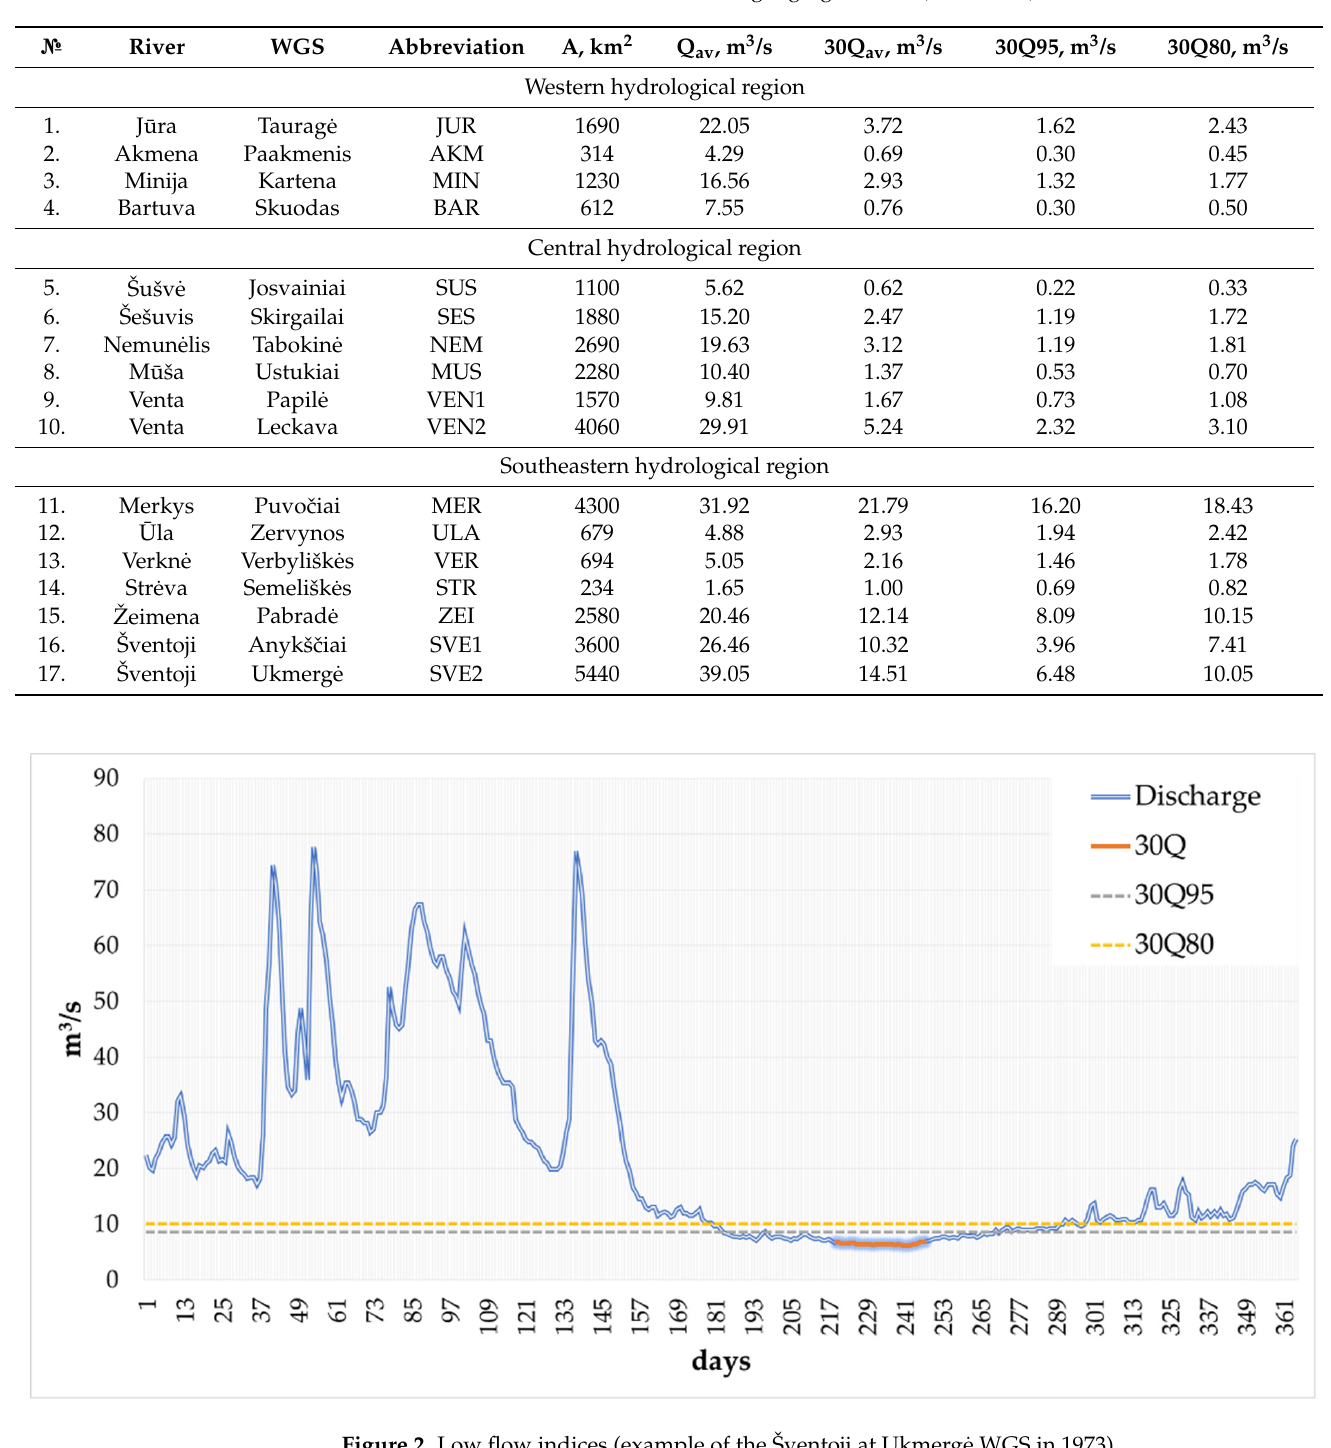
area in km 2 ). Modular coefficients for the low-flow period K = 30Q i /30Q av (30Q i is the discharge in year i, and 30Q av is the average discharge for the entire period of observa- tion) were used to estimate the regularities and to examine how low flows differed by decades (1961–2020) in the rivers from the different hydrological regions. This relative coefficient K enables a comparison of the rivers with different runoff values. To quantify the information incorporated in hydrographs, the HydroOffice software package [30] was applied. The HydroOffice tool FDC (flow duration curves; version 2.1) is often used to assess low flows. It was selected to calculate 30Q95 and 30Q80. FDC can be created from the entire imported time series or defined parts, such as annual or monthly segments. The HydroOffice tool TLM (threshold level or sequence peak algo- rithm methods; version 2.1) can be used to evaluate extreme flow conditions. Segments with extreme conditions can be statistically processed and visualized. TLM is designed to assess hydrological drought and flood events. Daily discharge and threshold values were used as input data for calculation with TLM, while drought period (duration), maximum deviation, and deficit volume were obtained as output data (Figure 3).